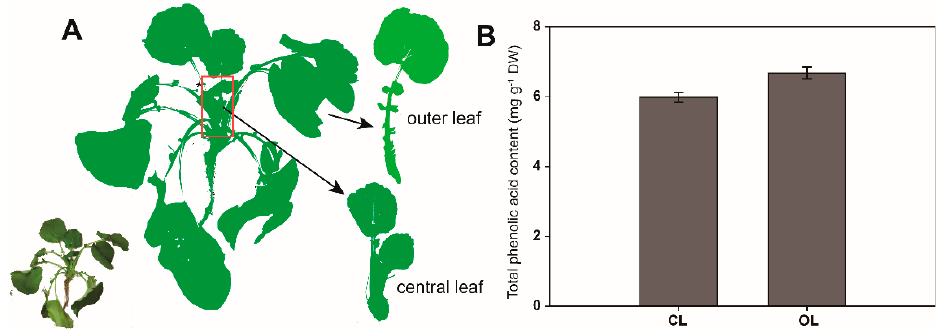
Figure 1. Schematic diagram of sampling ( A ) and total phenolic acid content ( B ) in C. violifolia leaves.